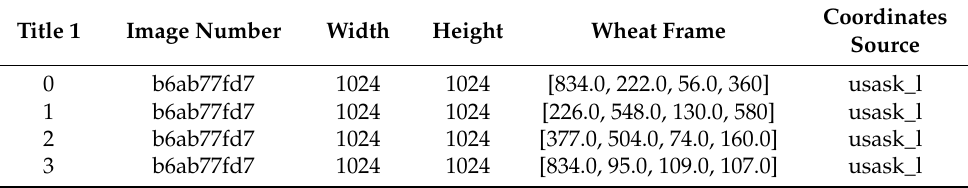
In Table 1: width, height (the width and height of the images in the dataset); wheat frame coordinates (the coordinates of the center point of the wheat bounding box in the image, as well as the length and width of the bounding box); source location (the source location of the wheat in the